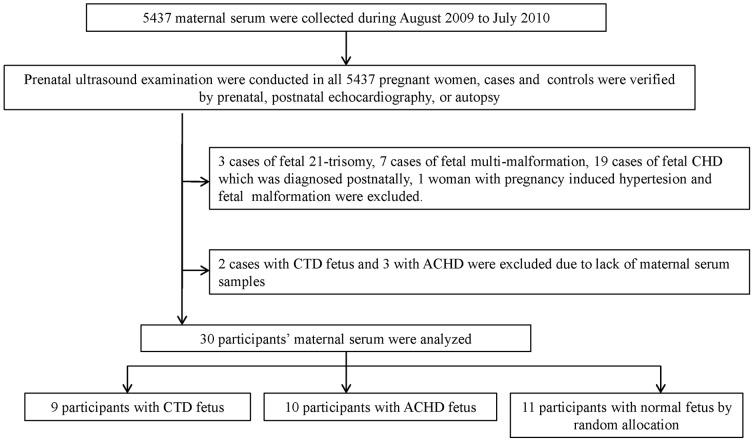
Flow diagram describing the selection of the analytical data set used for iTRAQ analysis.